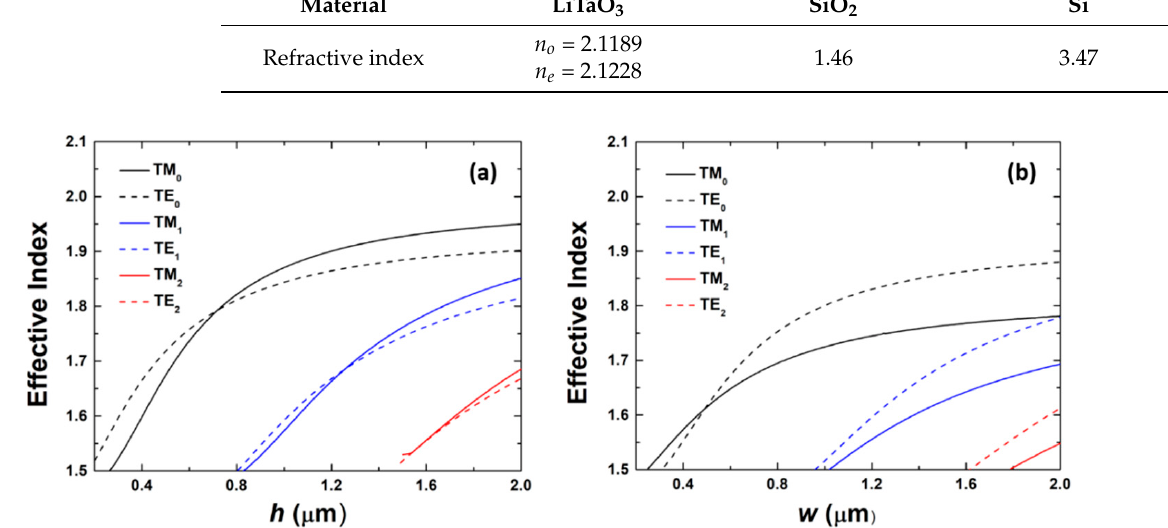
Figure 2. Graphs showing the effective index of the TE and TM light modes as a function of ( a ) the film thickness with a waveguide width of 0.7 µ m and ( b ) the waveguide width with a film thickness of 0.5 µ m in the LT waveguide. Both are calculated at λ = 1.55 μ m.